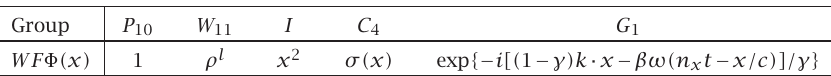
According to Table 3.2 for the field φ (cid:1) = φ with conformal dimension l = 0 and the linear homogeneous coordinate transformations from the group L 6 X (cid:4) 1 ∈ W 11 with ρ = ( 1 − β 2 ) 1 / 2 , the formulae were proposed by Voigt [13] and cited by Pauli [10]. In the plain waves case, they correspond to the transformations of the 4-vector k = ( k ,k 4 ) and proper frequency ω 0 according to the law k (cid:1)